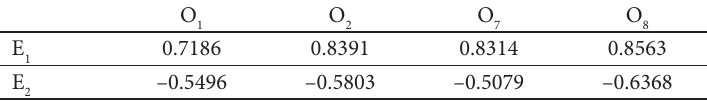
Table 4. Pearson correlation coefficient of output and environmental variables